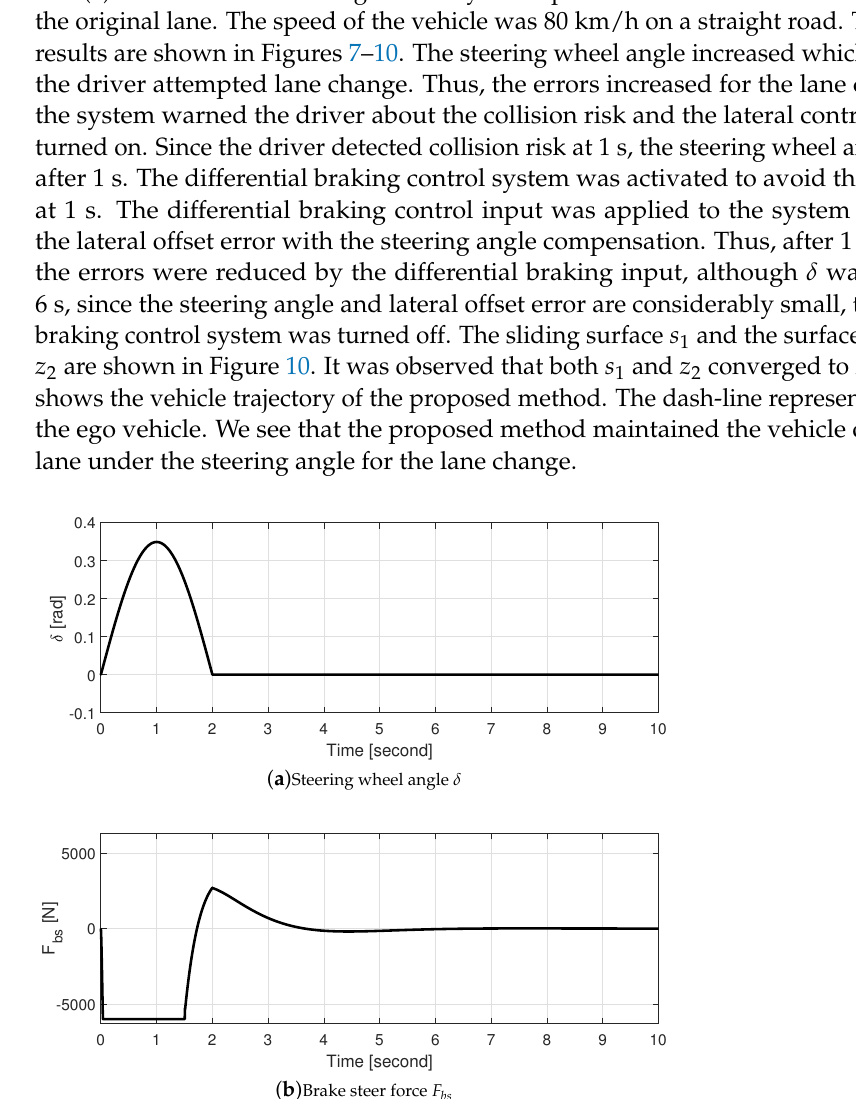
Figure 7. Steering angle and Brake steer force